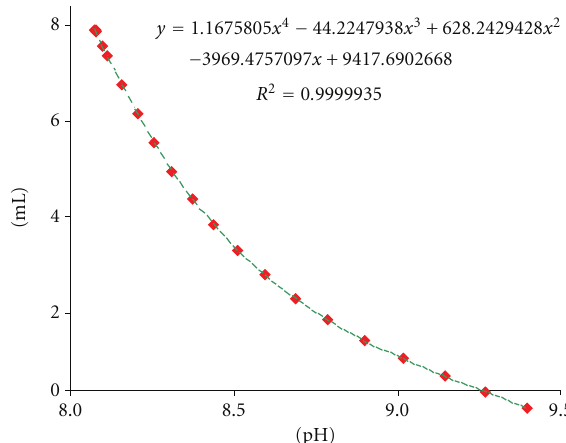
Figure 7: Graphical evaluation of the titration data of NaH 2 PO 4 / Na 2 HPO 4 -system.